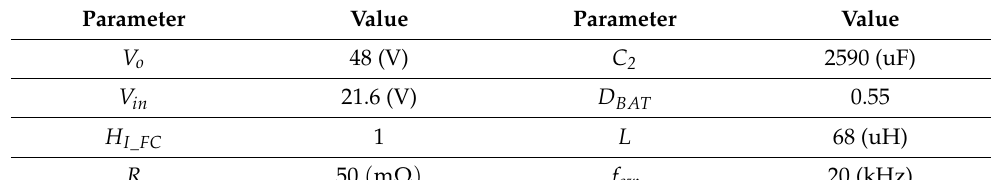
Table 6. Parameters of the BAT converter.